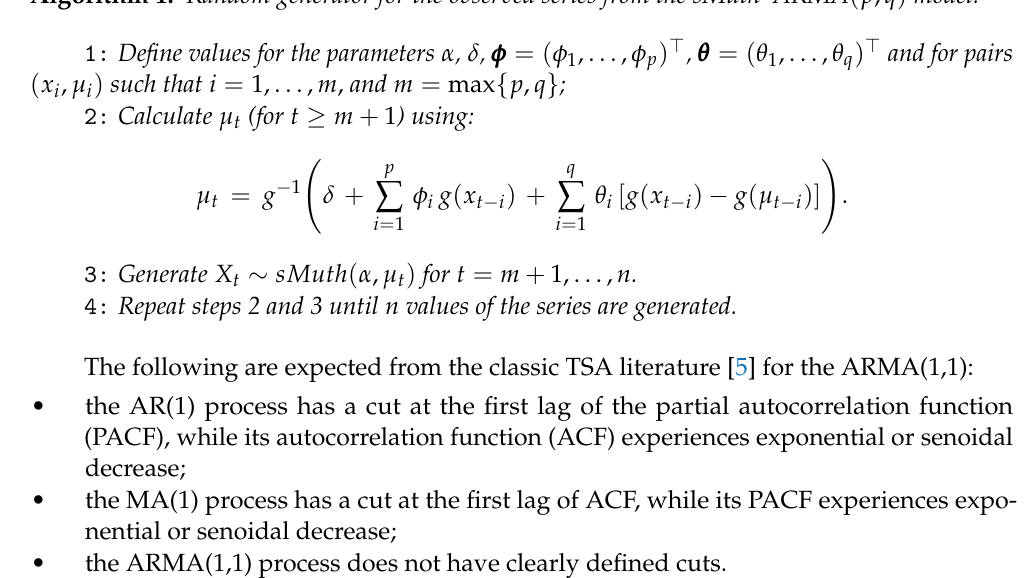
Algorithm 1. Random generator for the observed series from the sMuth–ARMA ( p , q ) model.